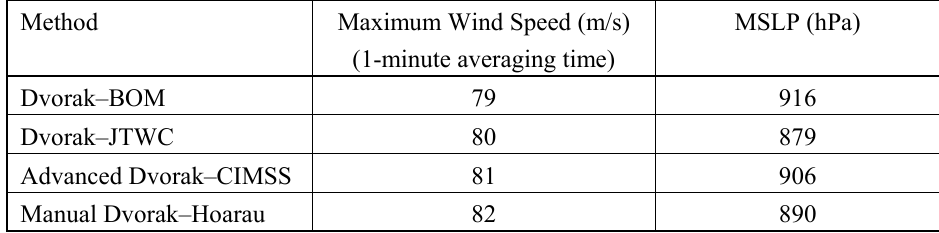
Table 2. Peak intensity estimates using dvorak-related